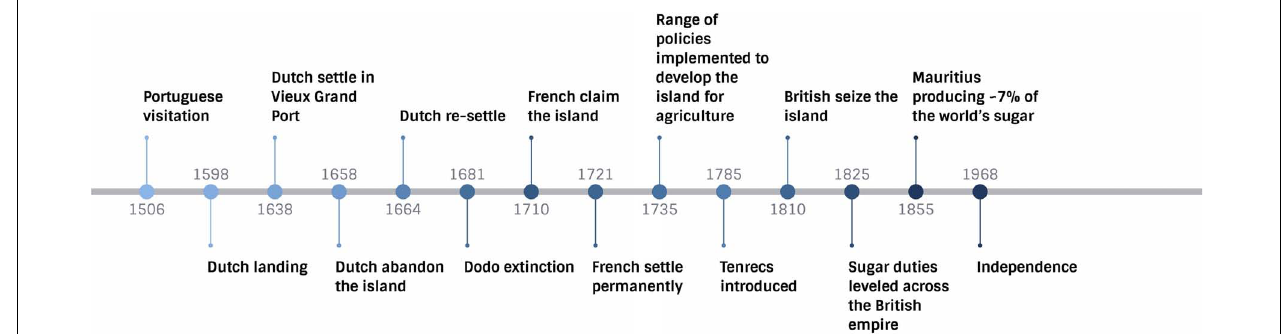
FIGURE 3 | Summary of main historical milestones catalyzing major ecological